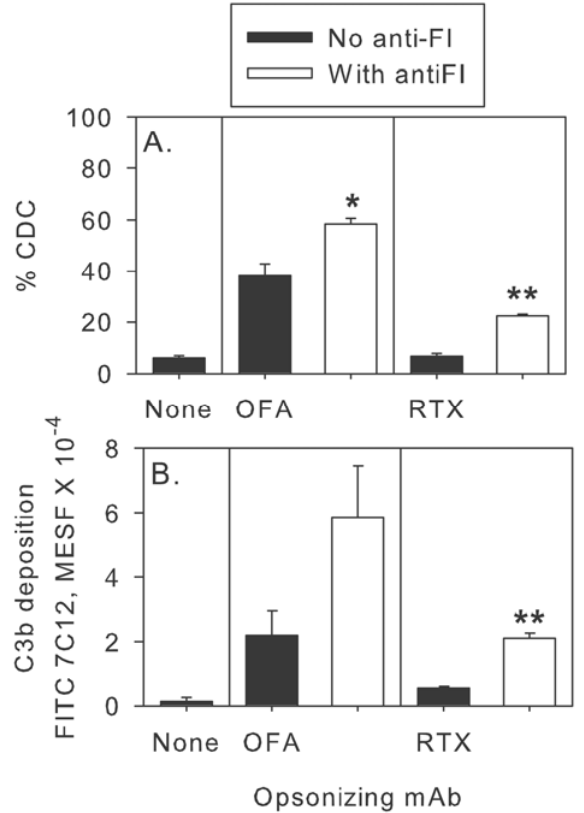
Figure 8. CDC and C3b deposition mediated by RTX or OFA of primary CLL cells are increased in the presence of mAb A247. PBMC isolated from CLL Patient E were incubated in the presence of mAb A247, 95 ug/mL OFA or RTX, and 48% NHS for 15 min at 37 °C. At the end of the incubation the samples were washed twice with ice cold BSA/PBS, resuspended in 2 mg/mL msIgG and probed with FITC mAb 7C12 at 10 µg/mL for 15 min at RT, washed once with BSA/PBS and finally resuspended in ToPro3.